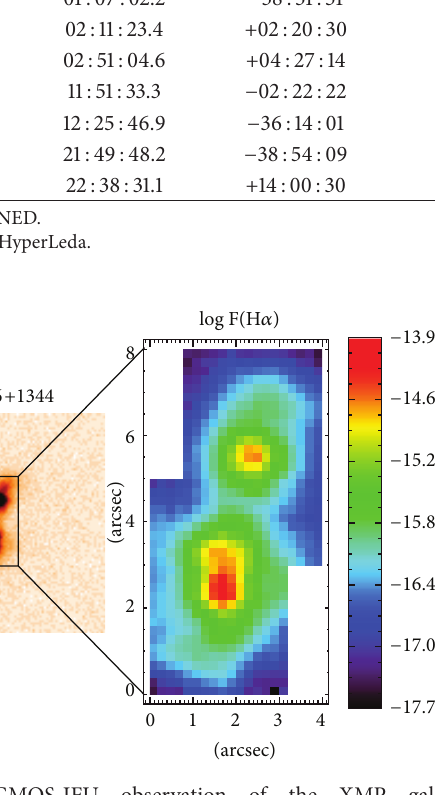
Figure 2: GMOS-IFU observation of the XMP galaxy HS2236+1344. Left: g-band acquisition image of the galaxy. The rectangle indicates the total field of view of 4 󸀠󸀠 × 8 󸀠󸀠 obtained from the composition of two different pointings with GMOS-IFU. Right: H 𝛼 map of the galaxy. log F(H 𝛼 ) in units of ergs cm −2 s −1 . Further details will be presented in a forthcoming paper